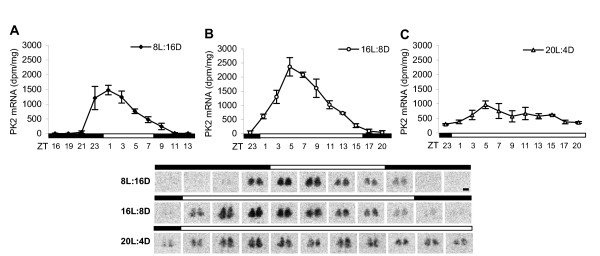
Effects of photoperiods on PK2 mRNA rhythm in the SCN. Temporal profiles of PK2 rhythm under 8L:16D (A), 16L:8D (B) and 20L:4D (C). Open and filled bars indicate light and dark periods, respectively. The zeitgeber time (ZT) on the x-axis reflects the timescale for each photoperiod. Each value represents the mean ± SEM of 3–4 animals. One-way ANOVA indicated that peak levels of all groups are significantly different from each other, p < 0.05–0.001 using Bonferroni's post-hoc test. Autoradiographic images show representative mRNA expression of PK2 during these photoperiods.